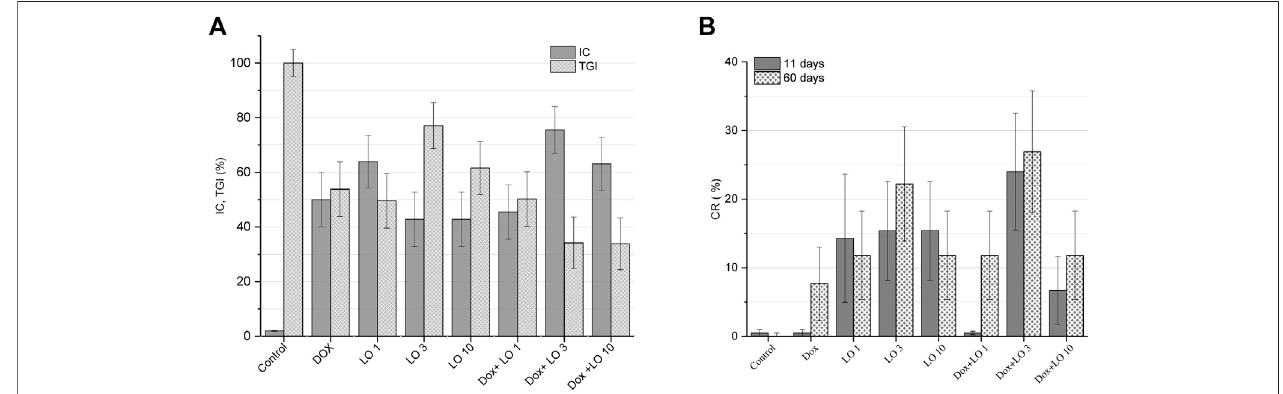
FIGURE 2 | PLS tumor growth inhibition coef fi cients (IC) 11 days after the start of treatment and tumor growth indices (TGI) corresponding to the whole treatment period (A) .Completetumorregression(CR)frequenciescalculated11and60 daysafterthestartoftreatment (B) .Thevaluesrepresentthemean%±SE (A,B) .Thedata correspond to two and three independent experiments.